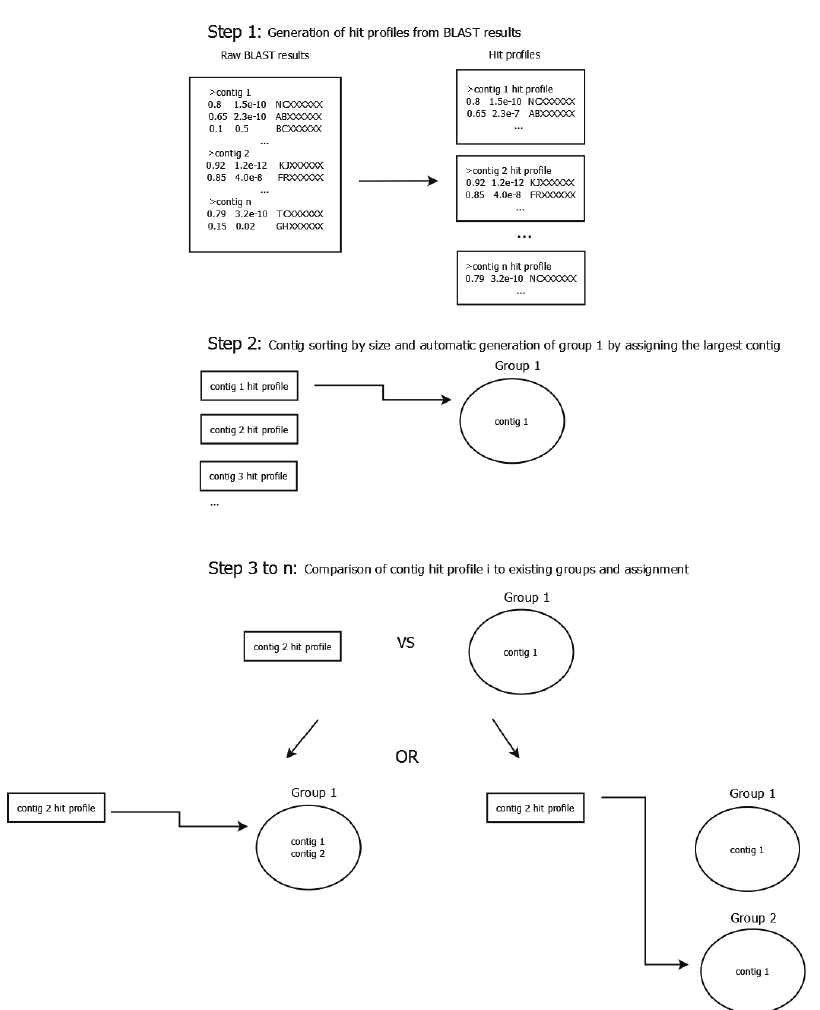
Figure 1. Schematic illustrating the contig grouping process. In a first step, a BLAST search against the non-redundant nucleotide collection is performed for all contigs. Afterwards, a hit profile is generated for each contig by applying a cutoff of 20% on the query coverage and 1 × 10 − 10 on the E -value to the raw BLAST results. During the second step contigs are sorted by size and the largest contig is automatically assigned to group 1. The third step consists of comparing the second-largest contig to all existing groups using the scoring system described in the text and either assigning the contig to the group with the lowest distance score or opening a new group if the lowest score is greater than 0.9. It is repeated until all contigs have been assigned (though some contigs may be the only member of their respective group).